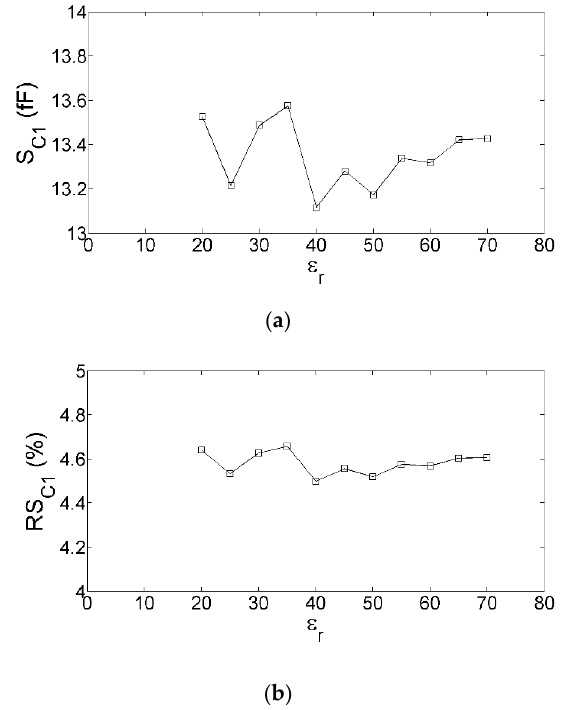
Figure 7. Behavior of the ( a ) absolute and ( b ) relative sensitivity of C 1 to variations in ε r for the lossless MUTs placed on top of the sensing area of the IDC sensor. The average values of S C1 and RS C1 are 13.35 fF / ∆ 1 and 4.58%,